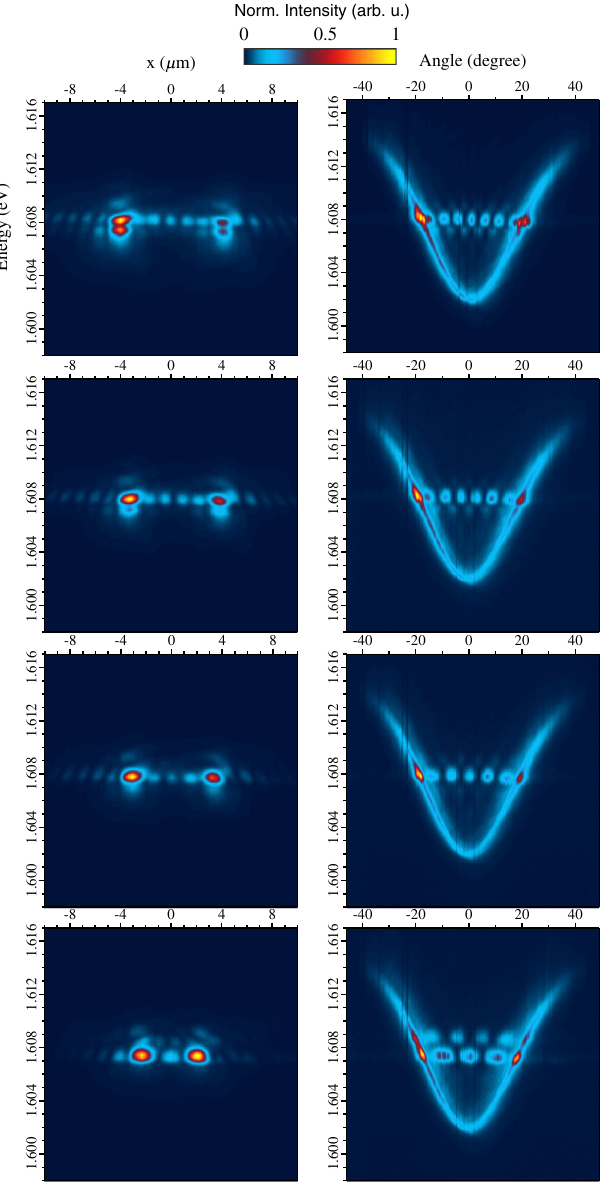
FIG. 3. Energy-resolved real- and Fourier-space images of two condensates are shown for different separation distances. The fringes in between the condensates are at the same energy with the